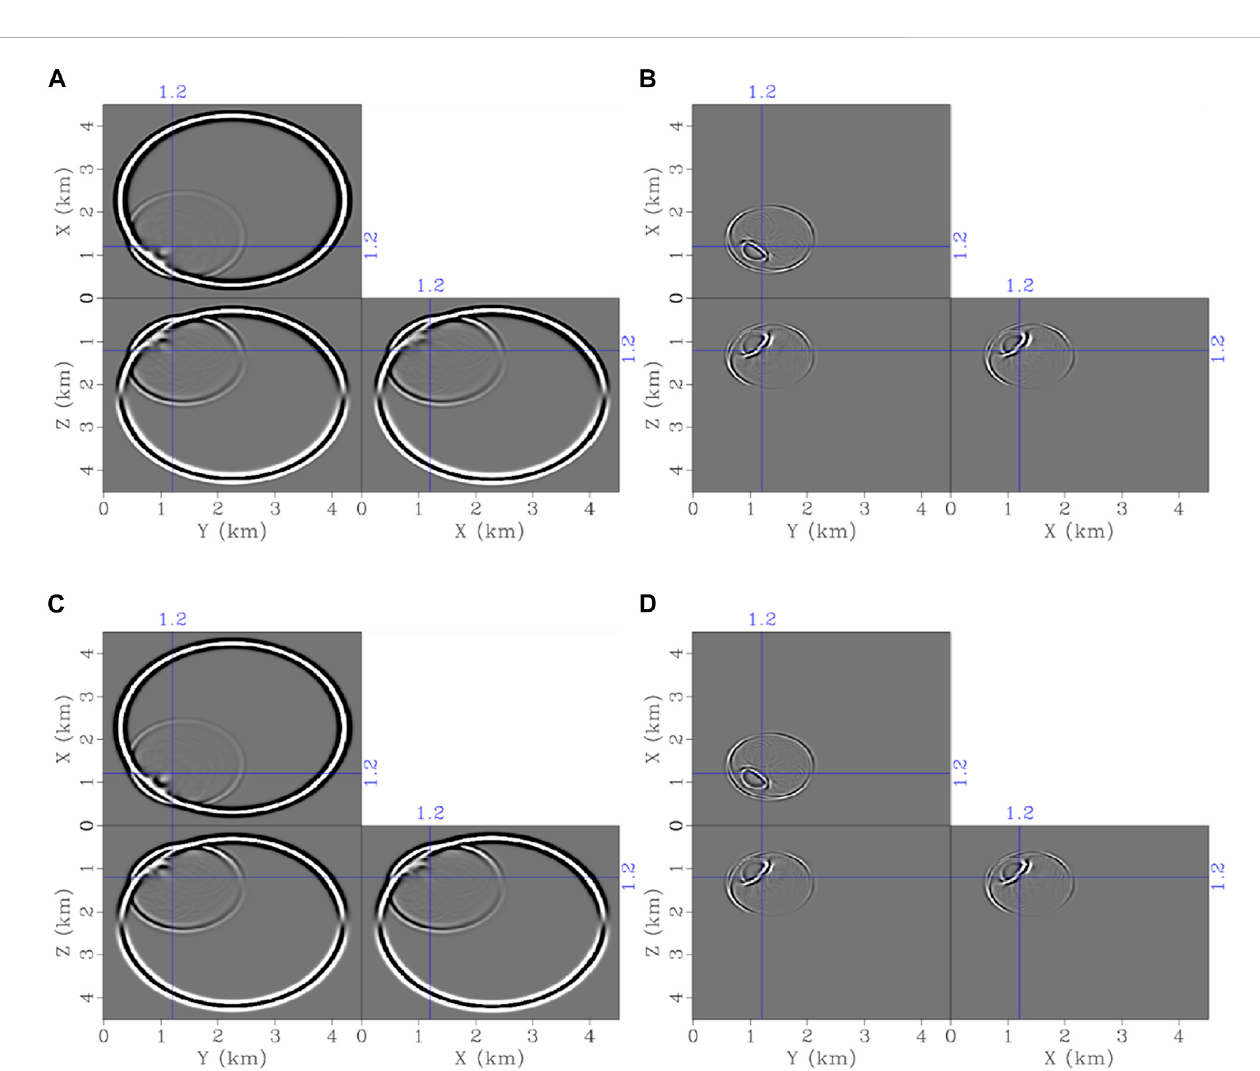
FIGURE 7 (A) and (B) P and S-wave fi eld snapshots v z obtained using the STS method, (C) and (D) P and S-wave fi eld snapshots v z obtained using the FTS method. The wave fi eld snapshots are recorded at 0.8 s with a time step of 2.0-ms time marching.